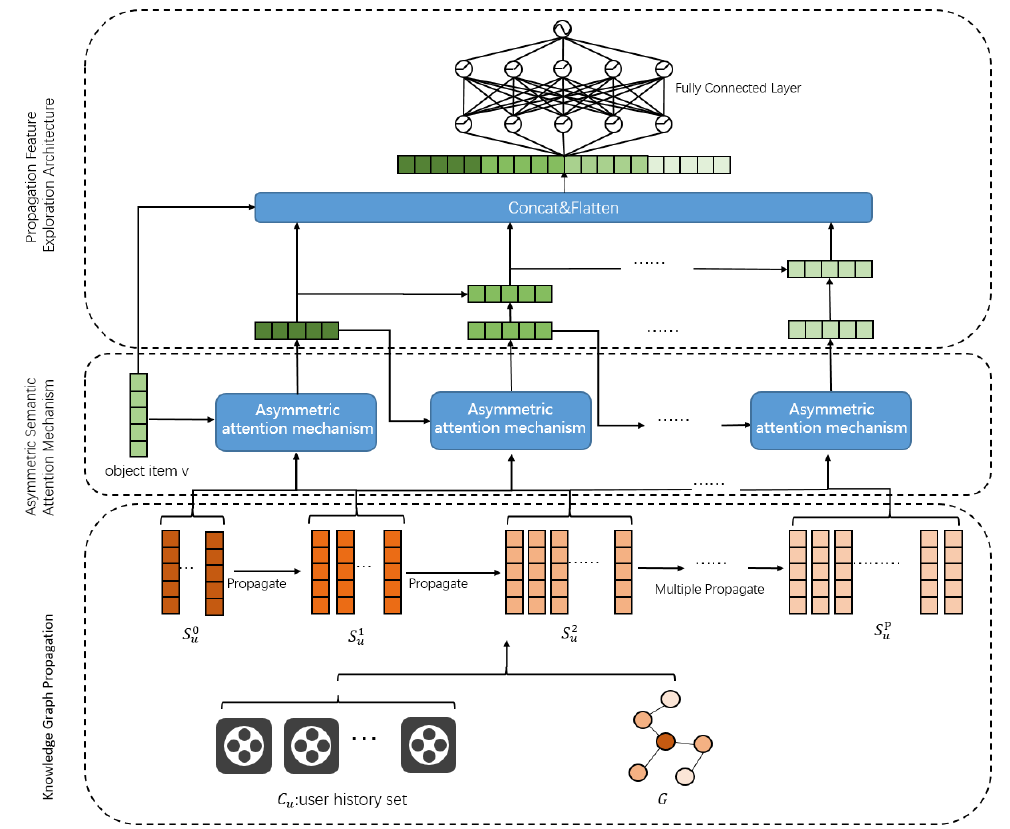
Figure 2. The overall framework of EKPNet.